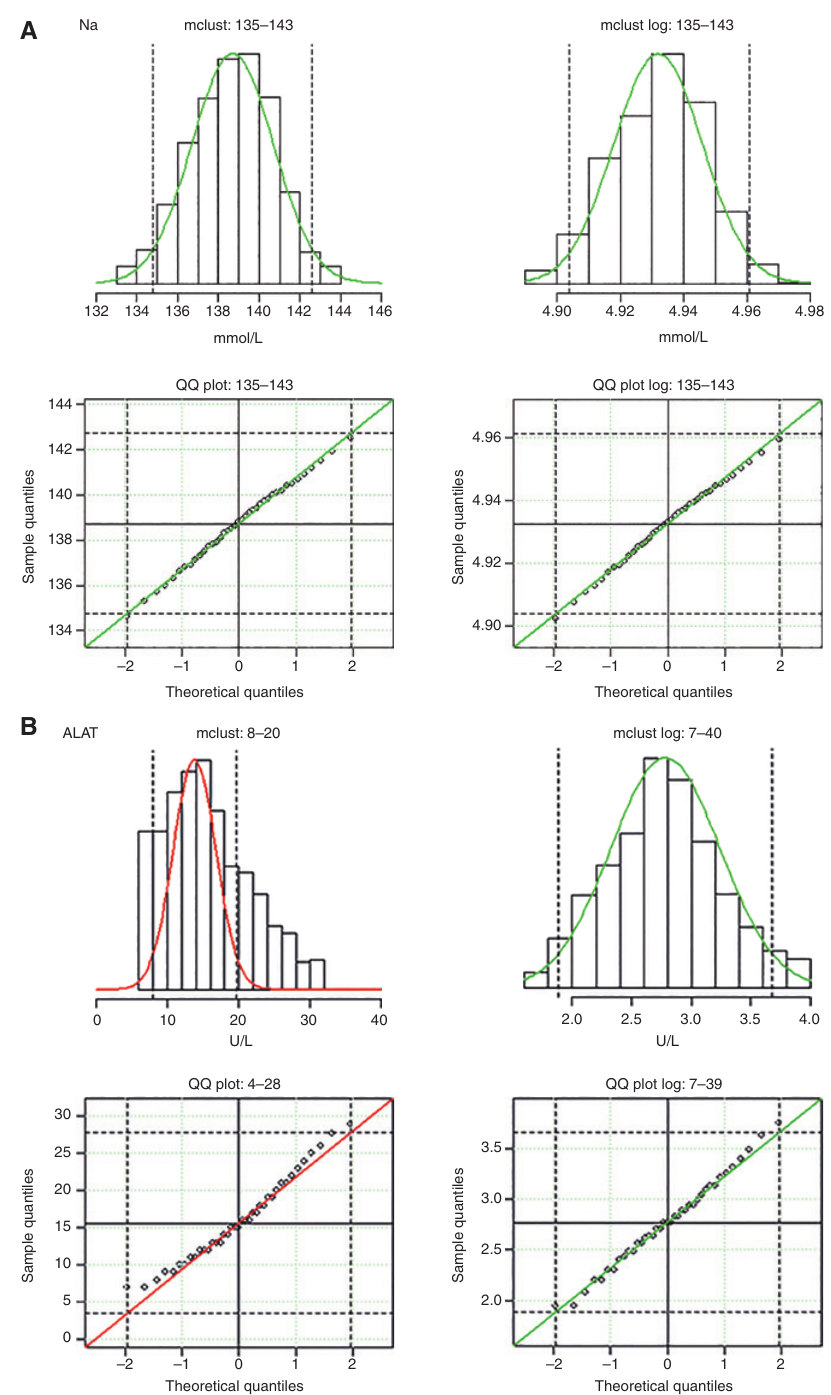
Figure 5: Comparison of distribution models in the context of reference interval estimation. Green lines indicate the confirmation of expected results, red lines indicate unexpected density curves and QQ plots. Left column normal distribution,right column lognormal distribution. Upper panel (A) sodium, lower panel (B)